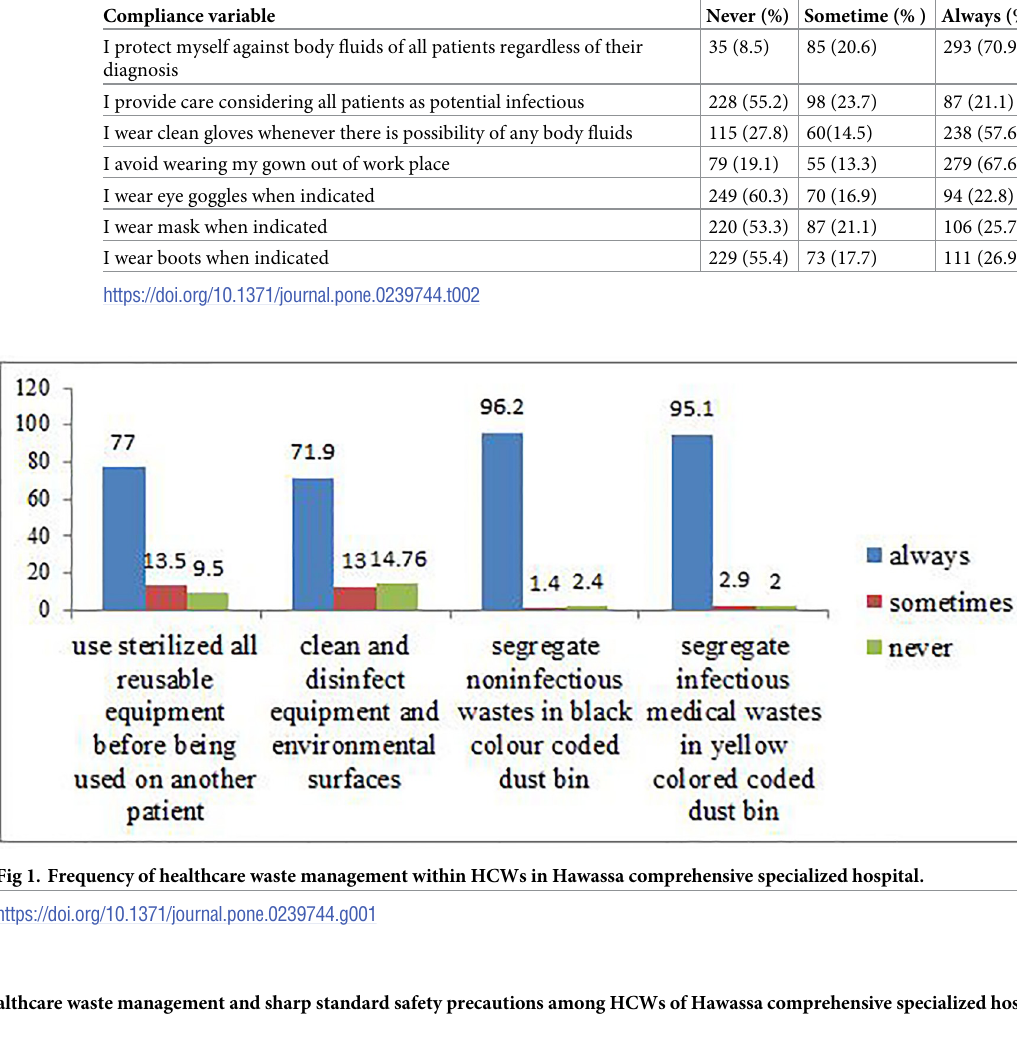
Table 3. Level of compliance with healthcare waste management and sharp standard safety precautions among HCWs of Hawassa comprehensive specialized hospi- tal, 2019. Compliance variables Never